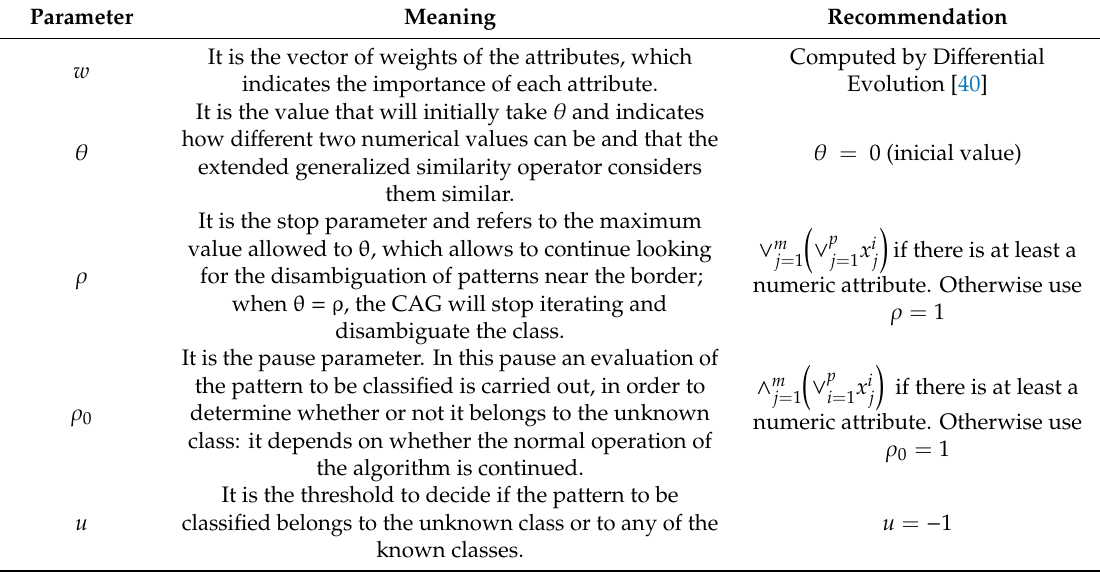
Table 2. Empirical values for the parameters of the Gamma